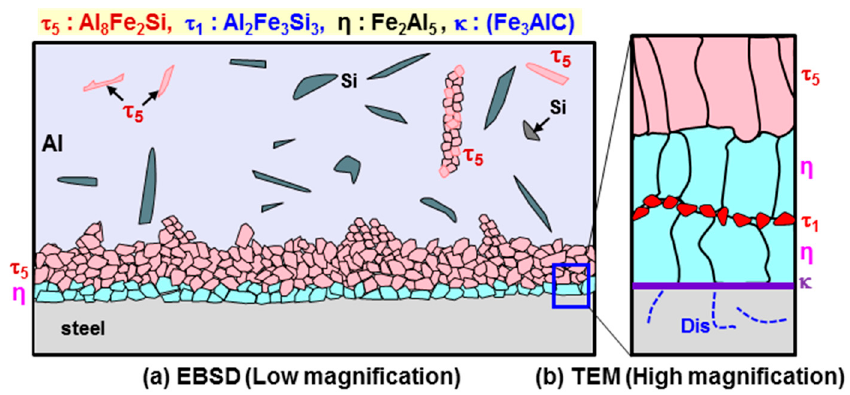
Figure 10. Schematics of the interface layer confirmed by ( a ) electron backscatter diffraction (EBSD) and ( b ) transmission electron microscopy (TEM) analysis. Table 3. Configuration of the phases in the reaction layer as found in the recent literature.